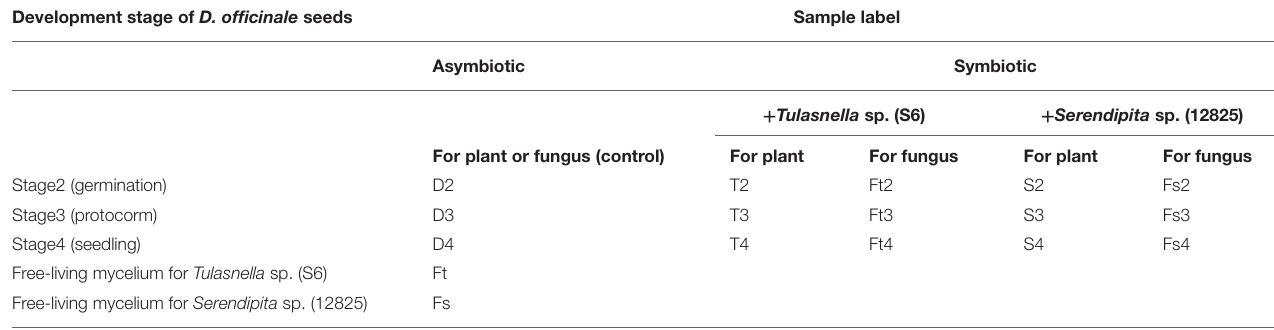
TABLE 1 | Samples information in our study. Development stage of D. officinale seeds Sample